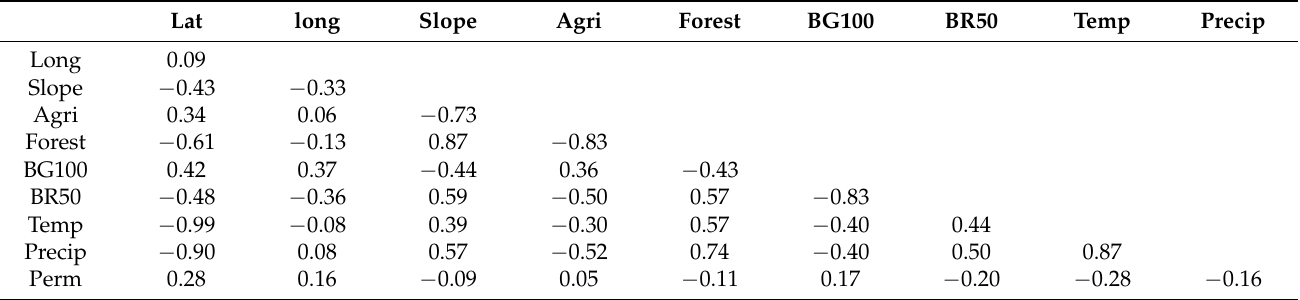
Table 1. Pearson correlations among key natural environment, climate, and land-use variables for 459 stream sites at the watershed scale in the State of Illinois, USA. (modified from [6]) with Long = longitude, Lat = latitude, Slope = average slop of the watershed (WT), Agri = percent agri- cultural land in WT, Forest = percent forests in WT, BG100 = percent WT with bedrock deeper than 100 feet (30.48 m), BR50 = percent WT with a bedrock of <50 feet, Temp = average annual air tem- perature in WT, Precip = average annual precipitation of WT, and Perm = average soil permeability of